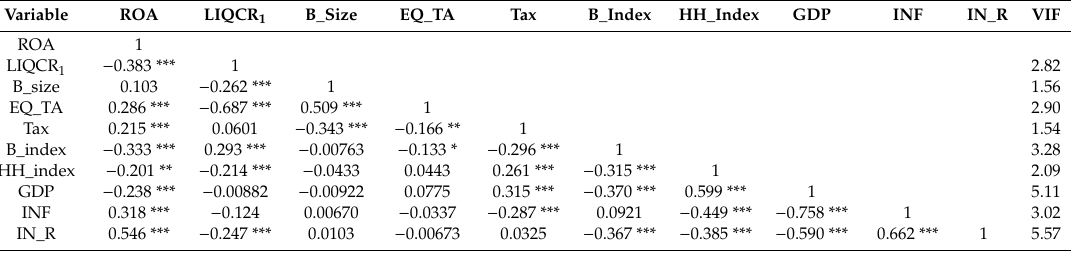
Table 5. Correlation matrix and the variance inflation factor (VIF).